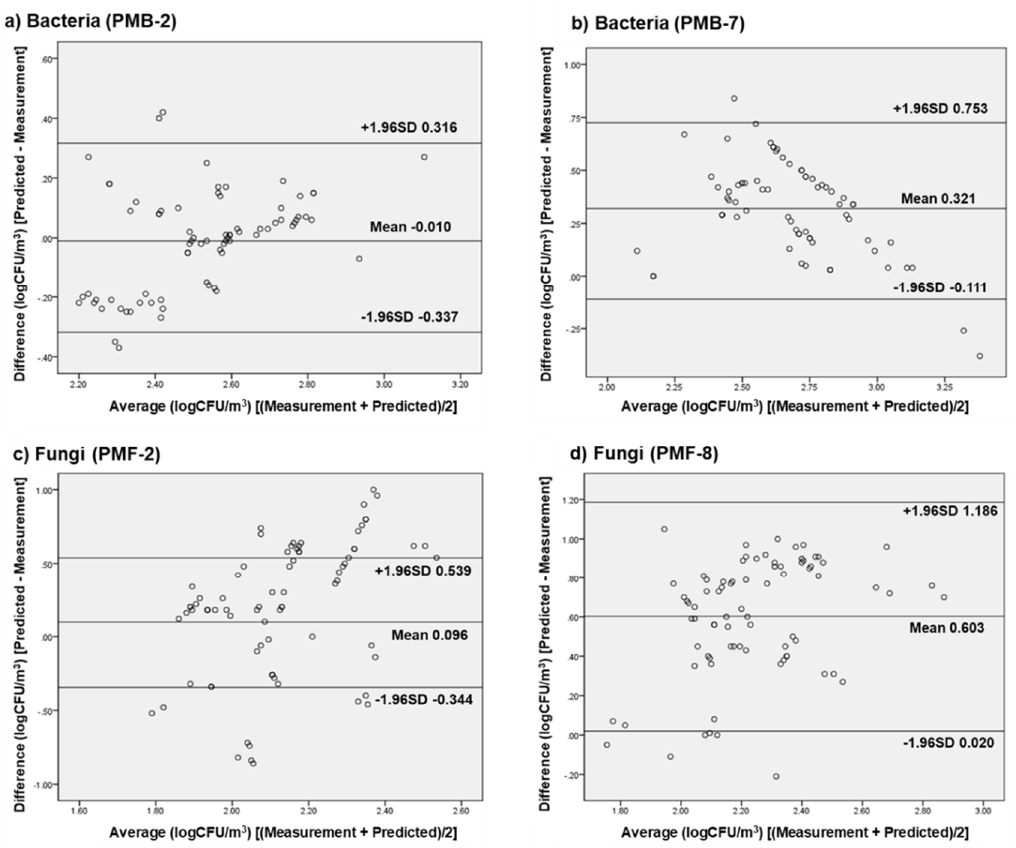
Figure 3. Comparison of biological aerosol concentrations between measured (actual) value and predicted value using the Bland–Altman plot. ( a,b ) Predictive models for bacterial bioaerosol and ( c,d ) predictive models for fungal bioaerosol.